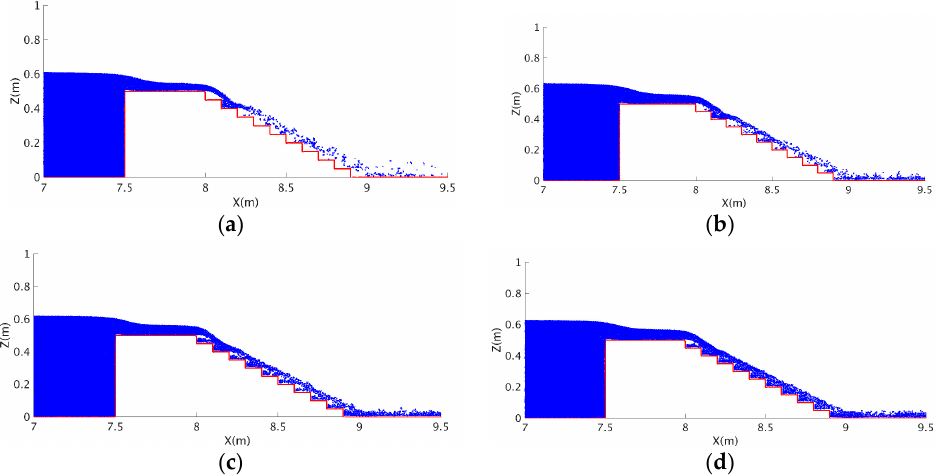
Figure 4. SPH particle snapshots of flow over the stepped spillway at different time t : ( a ) 1.2 s; ( b ) 2 s; ( c ) 8 s; ( d ) 12 s.